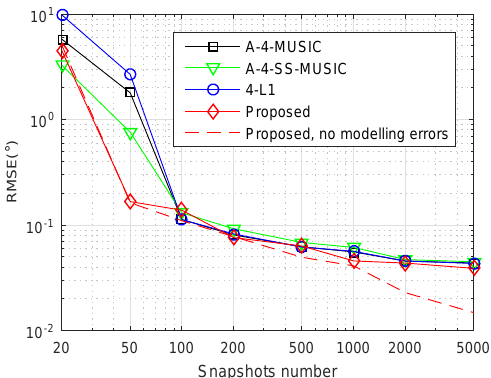
Figure 5. RMSE performance of four methods with modelling errors, S = { 1,2,4,11,25 } × d , K = 2, r = 0.1 ◦ , SNR = 3 dB.